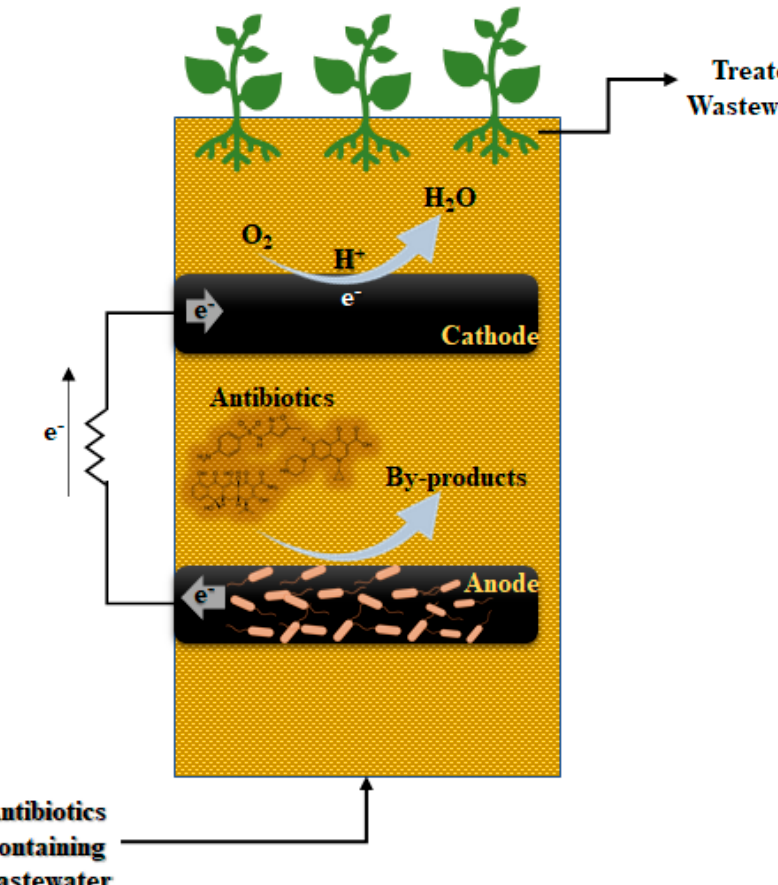
Figure 2. Schematic of an up-flow CW-MFC for removal of antibiotics from wastewater.